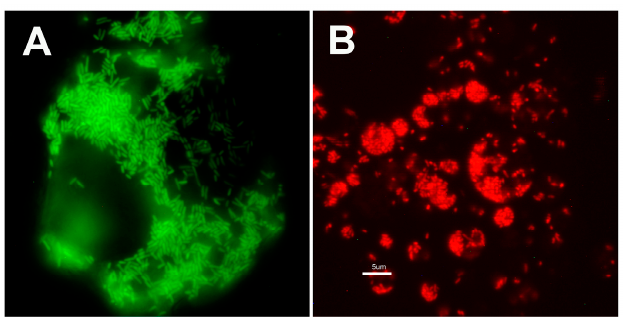
Figure 6. Images of Ixodes cells infected with Rickettsia buchneri and Rickettsia peacockii expressing GFP uv and mCherry. Panel ( A ) Fluorescence microscopic appearance of IRE11 cells infected with GFP uv expressing R. buchneri. Transformed R. buchneri were in the XX serial transfer when image was collected. Transformant is maintained in cell layers seeded at high cell density (1–5 × 10 6 cells per mL). Rickettsiae were visualized using fluorescence microscopy with FITC filter; ( B ) Fluorescence microscopic appearance of ISE6 cells infected with mCherry expressing R. peacockii . Rickettsiae were visualized using fluorescence microscopy with TRITC filter. All images taken using an upright Nikon Eclipse E400Diaphot fluorescence microscope. Bar equals 5 µm. Both images were collected at the same magnification.